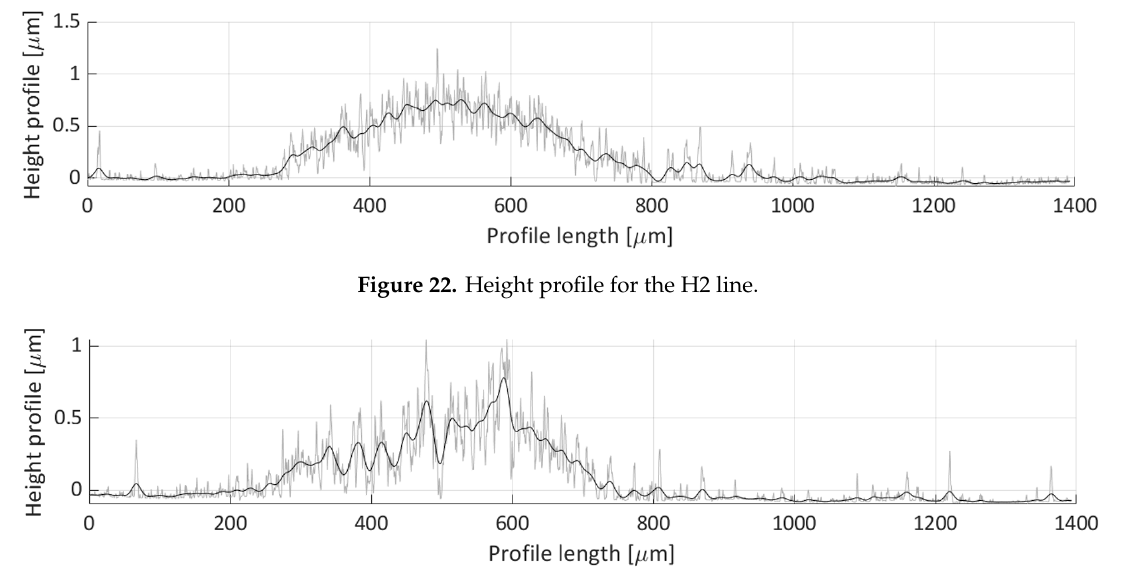
Figure 23. Height profile for the H3 line.